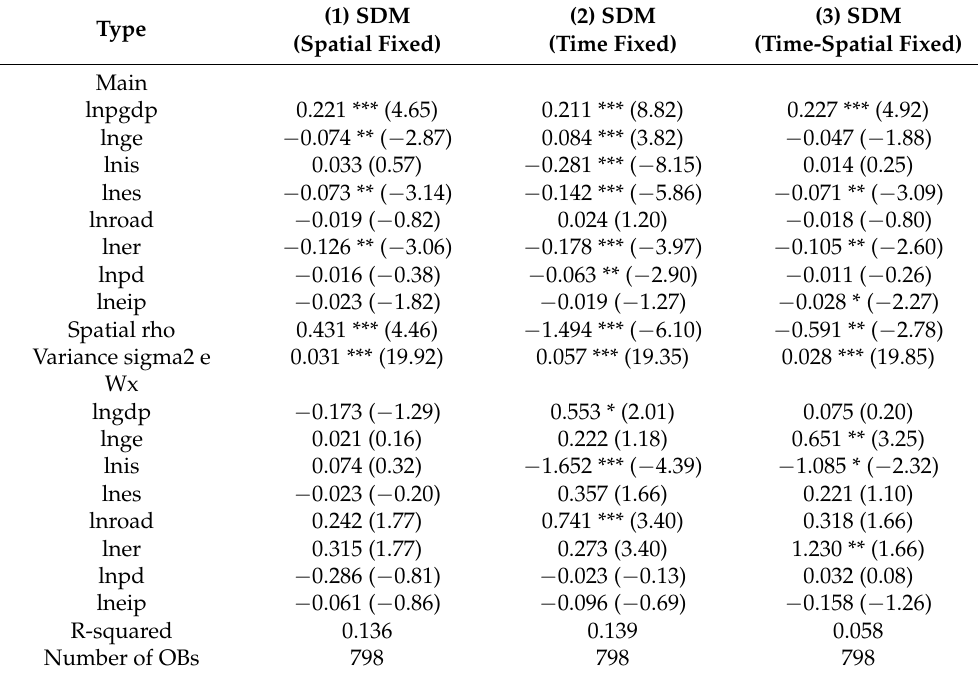
Table 5. Regression results of the SDM